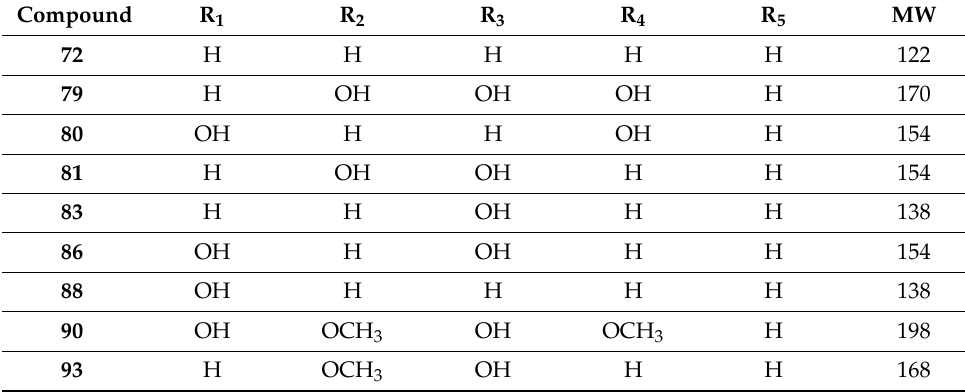
Figure 18. Chemical structure of compound 74 (MW = 354). Figure 19. Chemical structure of compound 87 (MW = 360). Denev